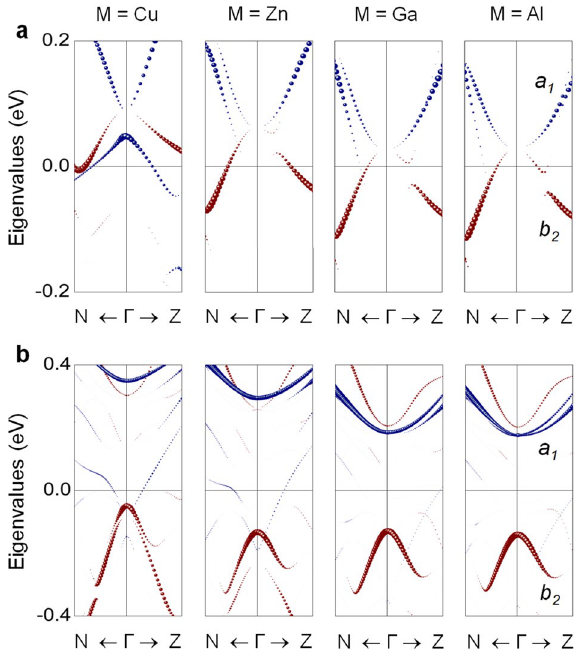
Figure 4. Spin-down channel eigenvalues of a 1 (blue) and b 2 (red) orbitals of the ( a ) Fe(4d) c atom in M-replaced Fe 16 N 2 and ( b ) Co c atom in M-replaced (Fe 0.5 Co 0.5 ) 16 N 2 along the high-symmetry N Ŵ Z line of the Brillouin zone for M = Cu−Ga and Al. The size of the symbols is proportional to their weights. The Fermi level is set to